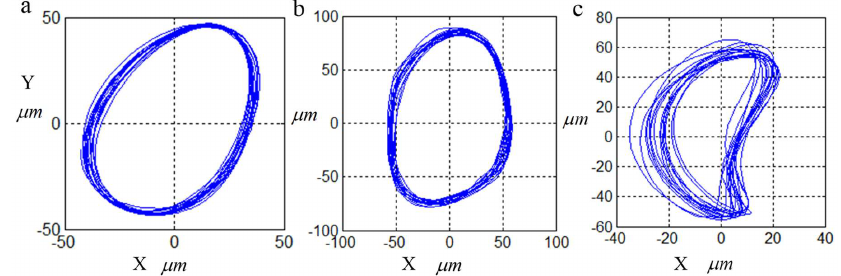
Figure 24. The axis orbits under different running conditions. ( a ) Normal; ( b ) Rubbing; ( c ) Misalignment.